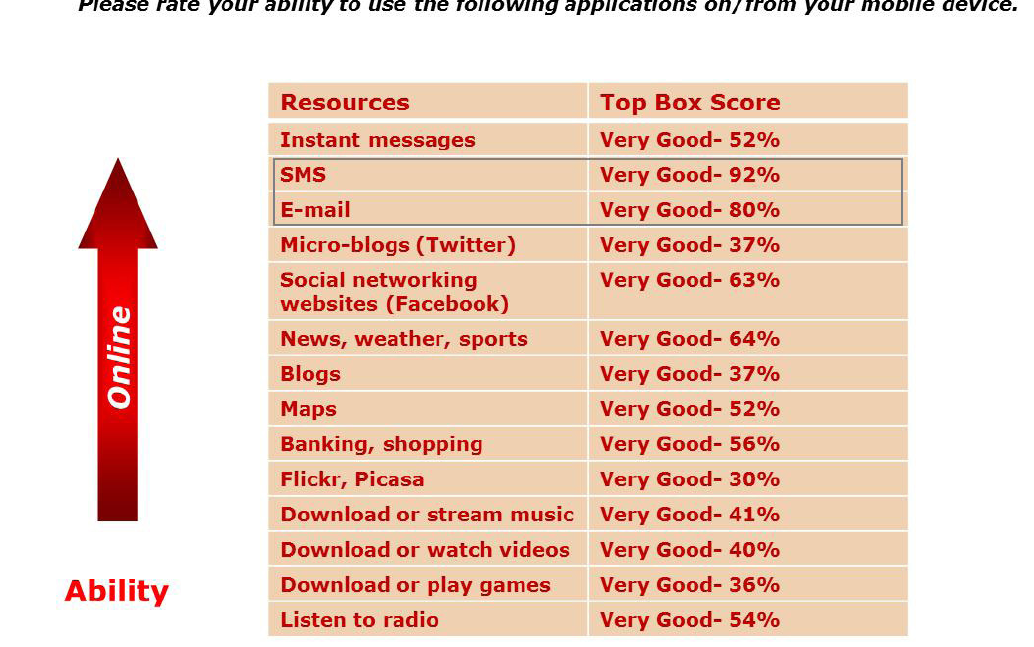
Figure 6. Ability to use a range of other resources on/from a mobile device (student self-